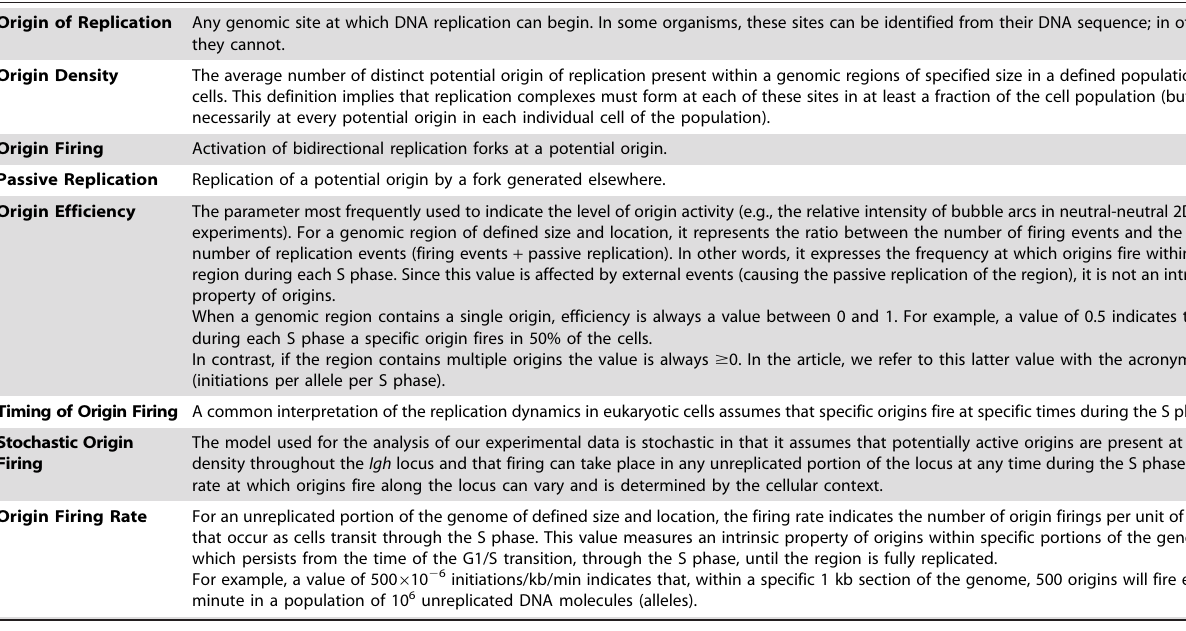
Table S1. Note that initiation events and fork collisions spanning adjacent restriction fragments are not shown in the figure since